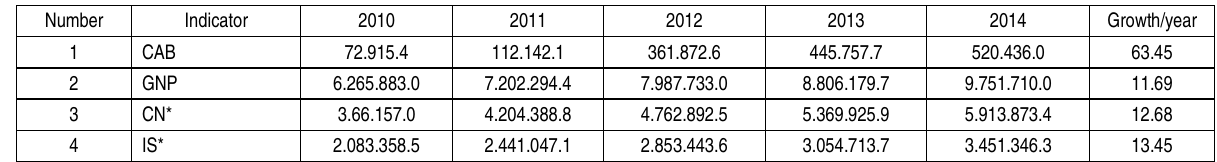
Table 1. National income, domestic absorption, and Indonesian current account